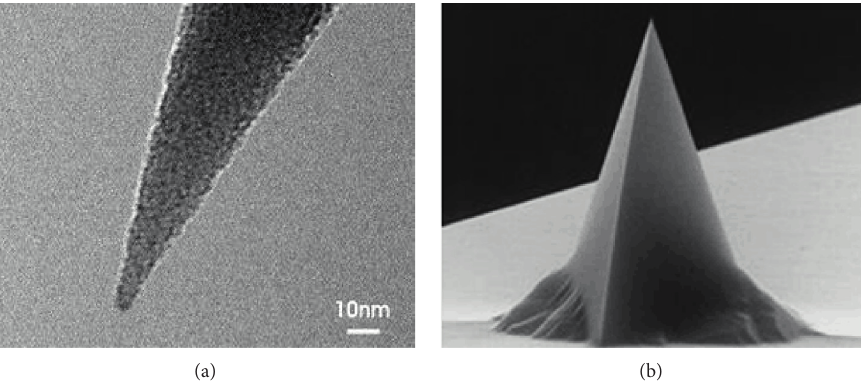
Figure 1: Morphology of AFM probe tip: (a) micrograph of TEM for probe tip; (b) the shape diagram provided by the production